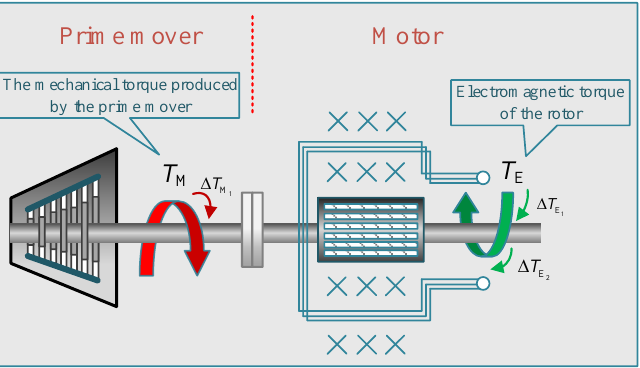
Figure 4. Shafting diagram of a synchronous set.